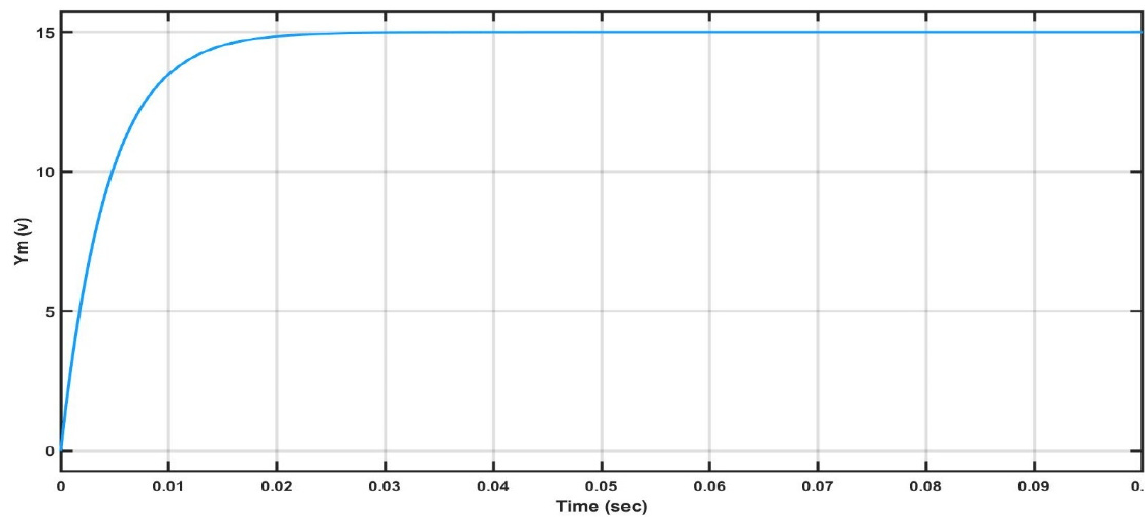
Figure 7. Model reference block output .